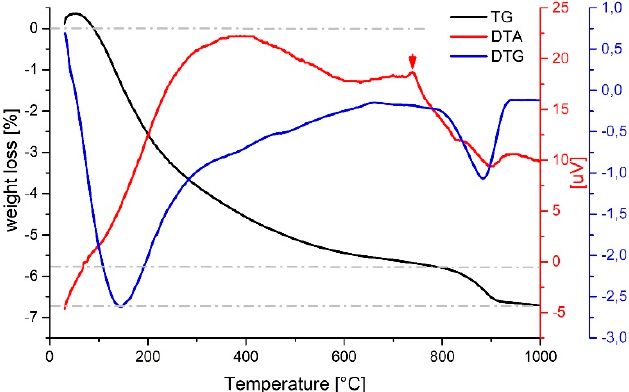
− DTA curves of BT Figure 1. TGA − DTA curves of BT powders. Figure 1. TGA